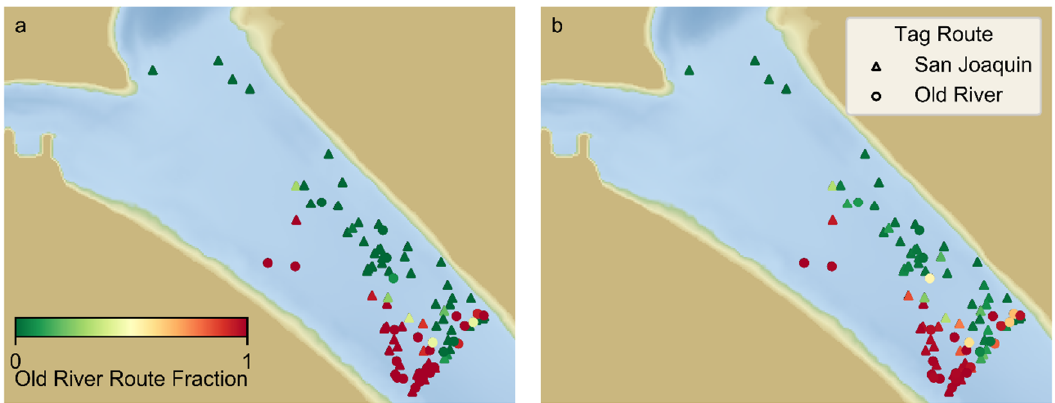
Figure 6. Entry points and associated route selection of salmon (marker shape) and particles (marker color) where yellow indicates roughly 50% Old River route selection for: ( a ) passive particles; ( b ) combined behavior of surface orientation, rheotaxis and CRW.